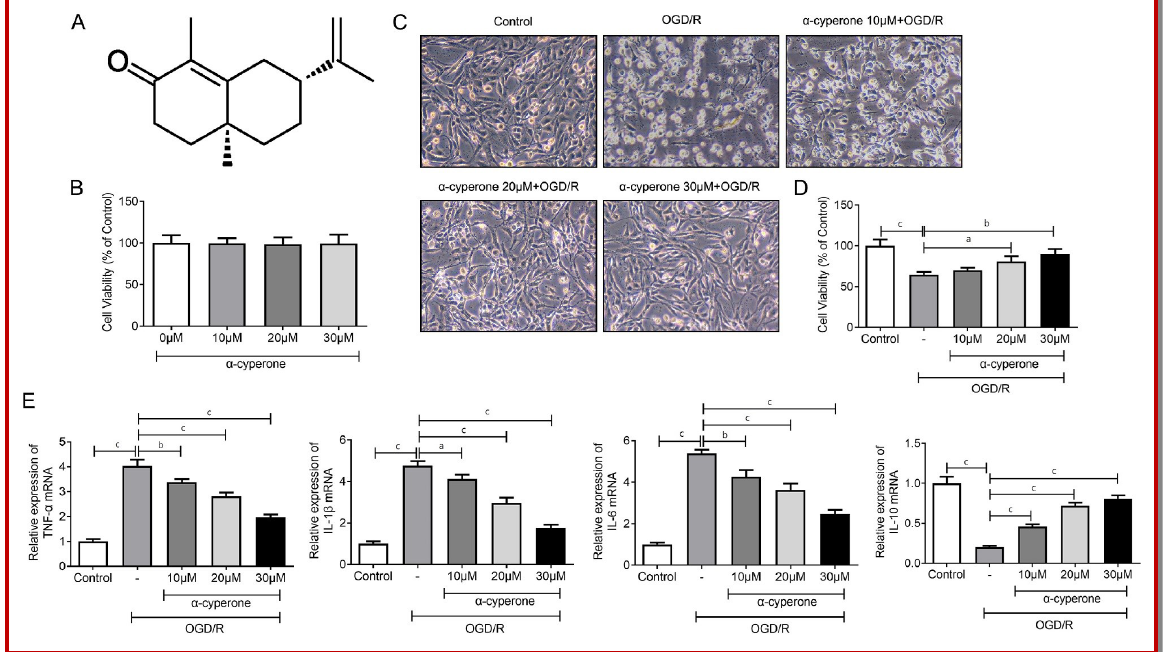
Figure 1: α -Cyperone reduces OGD/R-induced damage to neuronal viability and alleviates inflammation. The chemical structure of α -cyperone (A). The effect of gradient concentrations of α -cyperon on PC12 cell viability was determined using a CCK-8 assay (B). Following the cells were induced by OGD/R, cell viability and cell morphology were assessed (C-D). The levels of inflamma- tory factors in the cells were determined using RT-qPCR analysis (E). a p<0.05, b p<0.01, c